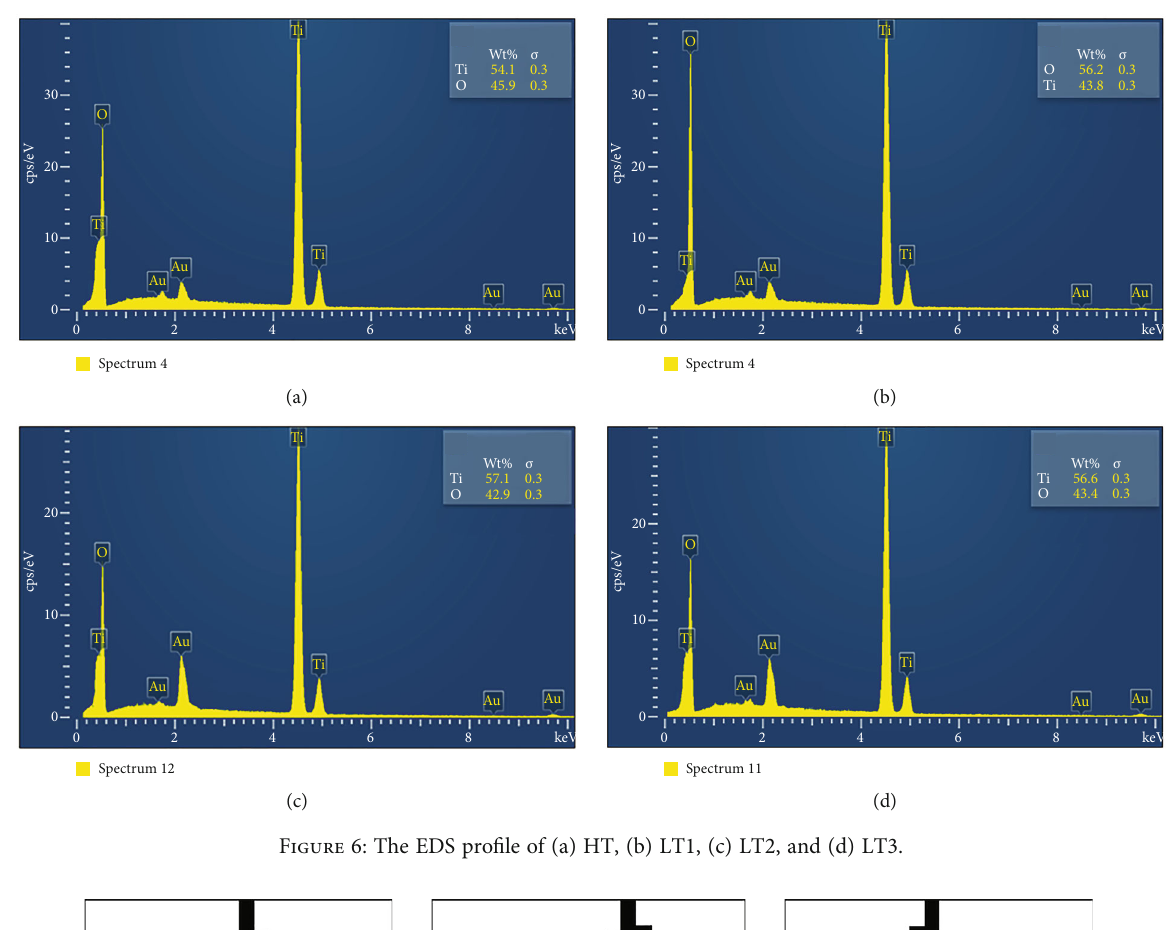
Figure 6: The EDS pro fi le of (a) HT, (b) LT1, (c) LT2, and (d) LT3.